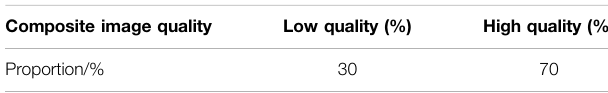
TABLE 1 | Quality statistics for composite images.